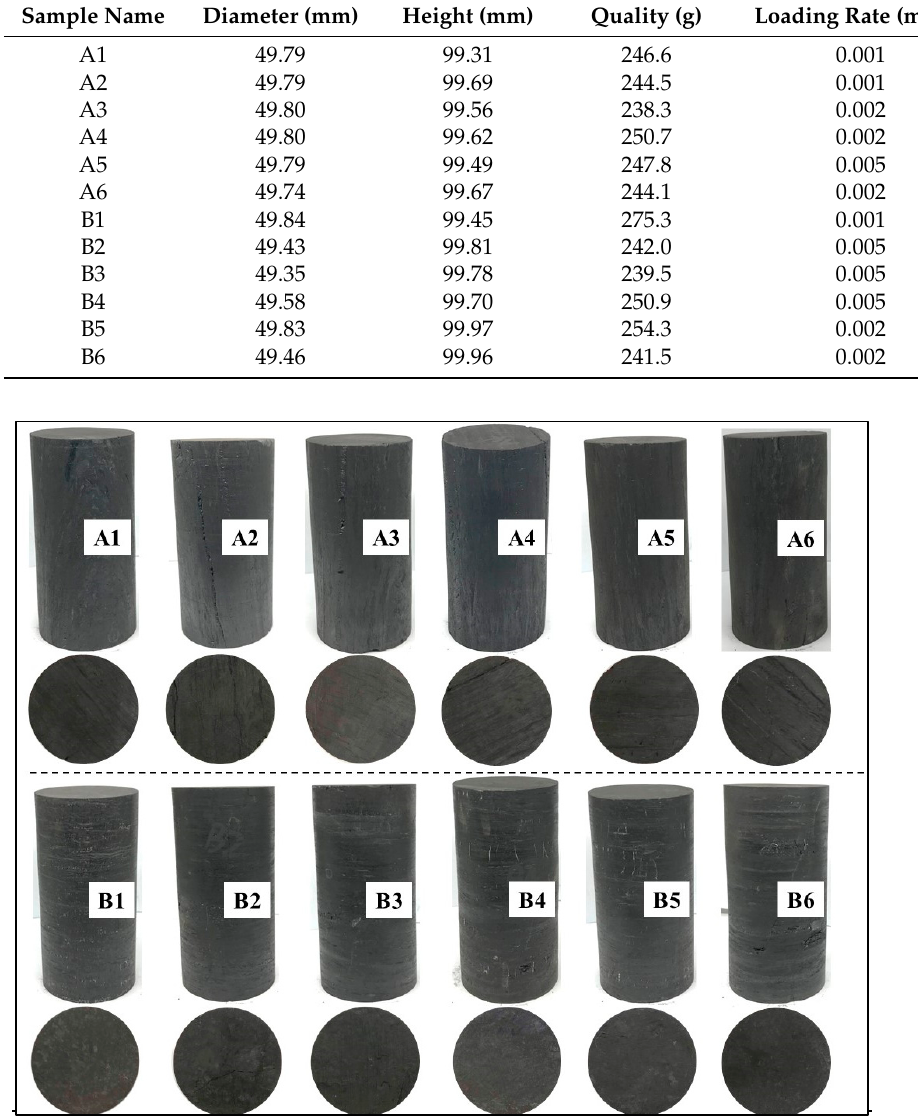
Figure 2. Photographs of the rock samples used in the study. Bituminous coal samples A1 to A6 were obtained along the bedding direction and bituminous coal samples B1 to B6 were obtained perpendicular to bedding.